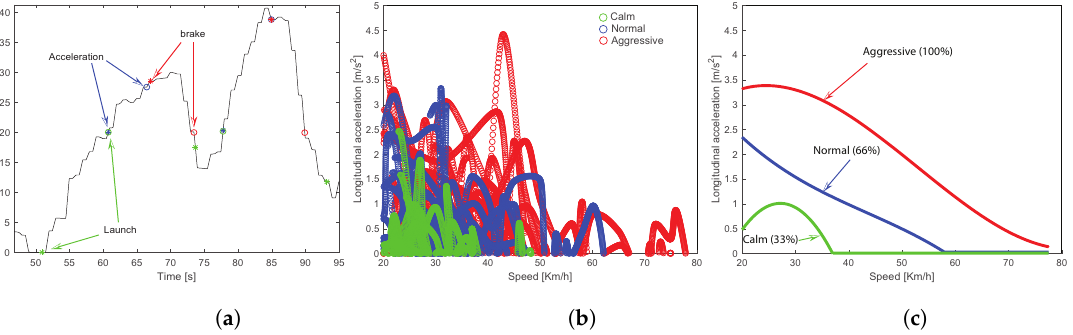
Figure 14. ( a ) Event detection: launch event in green, acceleration event in blue and brake event in red. ( b ) Feature extraction: each measurement is classified as aggressive, normal and calm style. ( c ) Score map: it corresponds to the 90th percentile value of each class of driving style.